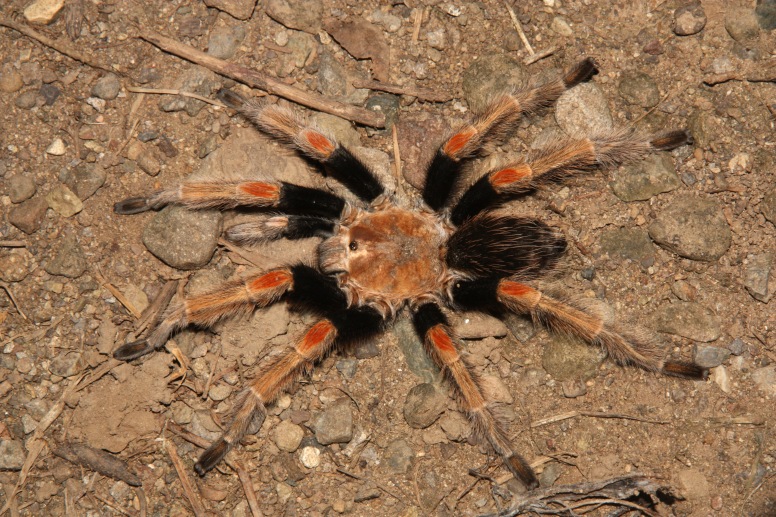
Brachypelma
baumgarteni Smith, 1993 male near Lázaro Cárdenas, Michoacán state, Mexico. Photo: Stuart J. Longhorn.